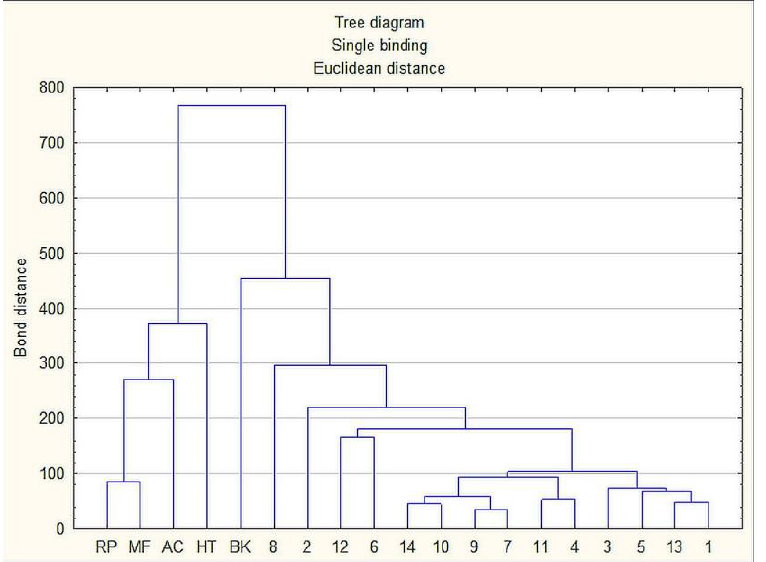
Figure 7. Tree diagram based on the average values of the physicochemical parameters and antioxidant activity between honeydew honeys and nectar honeys (complete linkage, Euclidean distance). (RP — rape, MF — multifloral, AC — acacia, HT — heather, BK — buckwheat) .